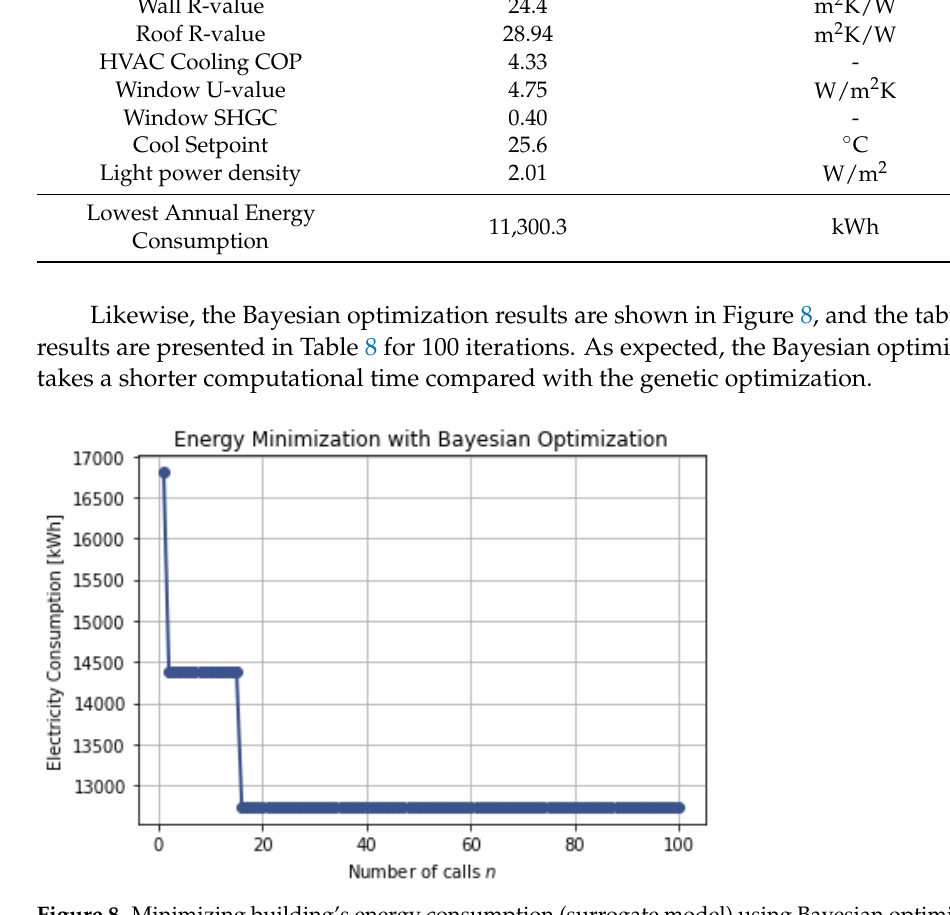
13 of 16 Table 7. Optimal design variables obtained from GA optimization. Parameter